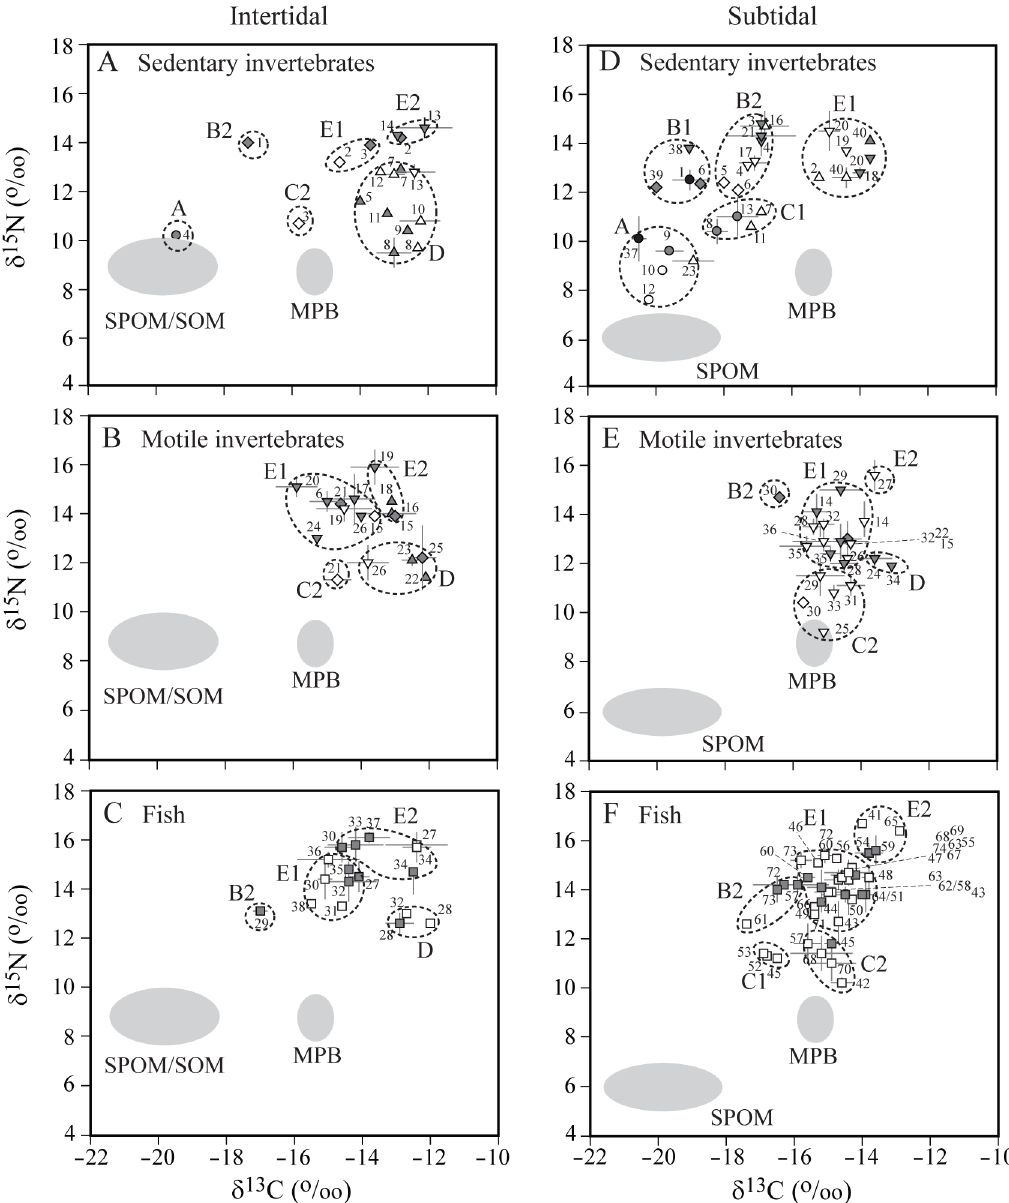
Fig 7. Dual plots of mean δ 13 C and δ 15 N values for sedentary and motile invertebrates, and fish in spring (white) and fall (gray) in (A − C) intertidal and (D − F) subtidal habitats. The groups of taxa were clustered according to the result of hierarchical cluster analysis (see details in Methods). Numbers designate different taxa (see Table 1 for species code). Circle, suspension feeder; triangle, deposit feeder; diamond, omnivore; inverted triangle, carnivore and scavenger; square, fish. Grey ellipses represent potential sources of organic matter: SPOM, suspended particulate organic matter; SOM, sedimentary organic matter; MPB,